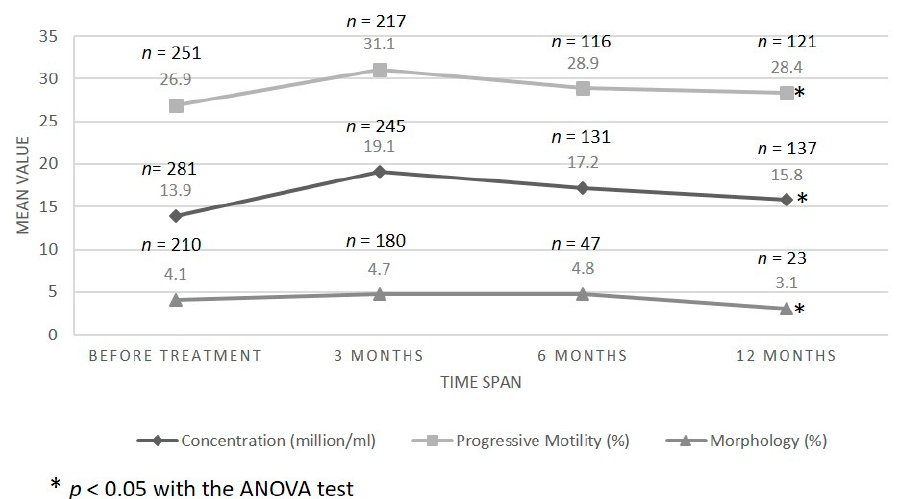
Figure 1. Evolution of sperm parameter mean values according to patient follow-up time. Sperm concentration, progressive motility, and morphology were assessed according to WHO criteria [21].